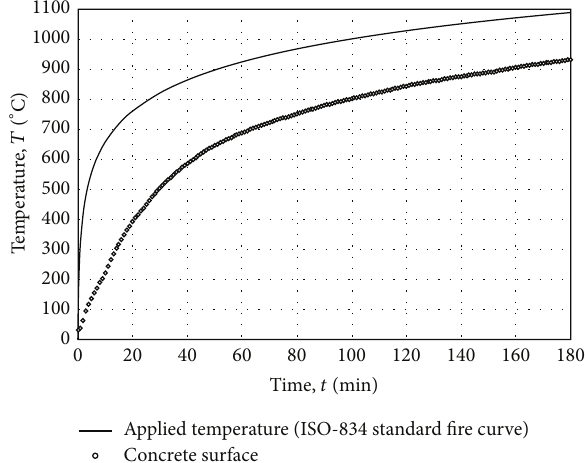
Figure 11: The difference in ISO-834 fire curve and the observed temperature on the surface of RC column confirming the unsteady- state conditions of the test measurements.